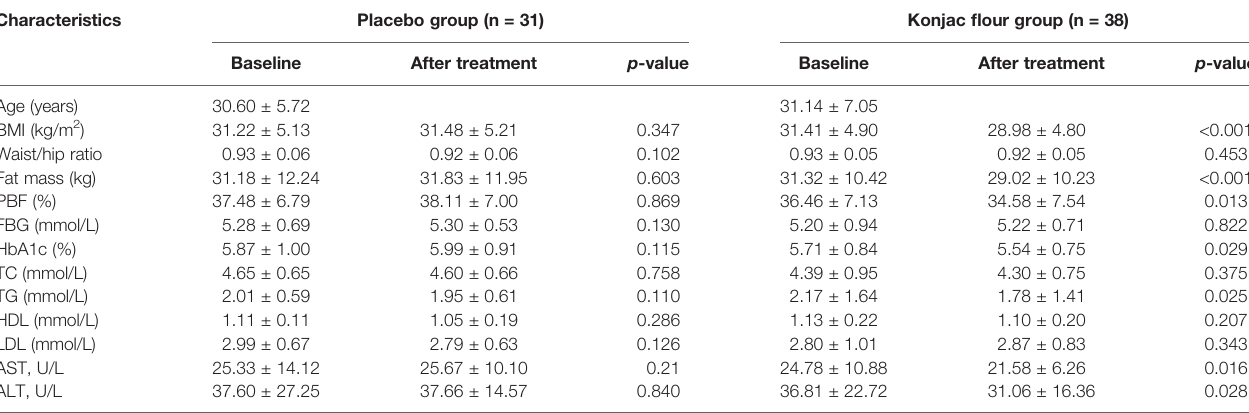
TABLE 1 | Obesity index and blood parameters in obese patients at the baseline and/or after placebo and KF treatment.